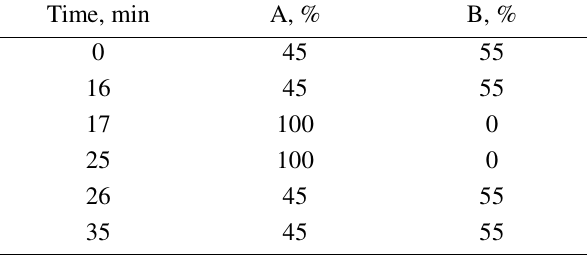
Table 6 . Gradient elution system in LC-MS/MS